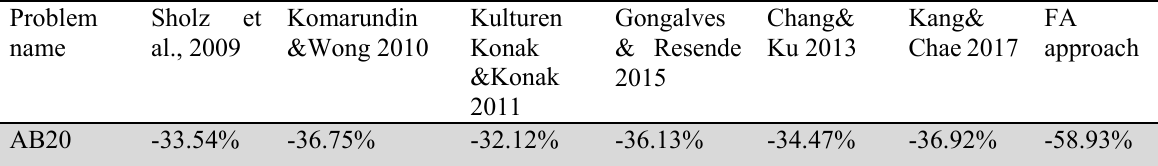
Comparison of results in terms of reduction of Material handling Cost